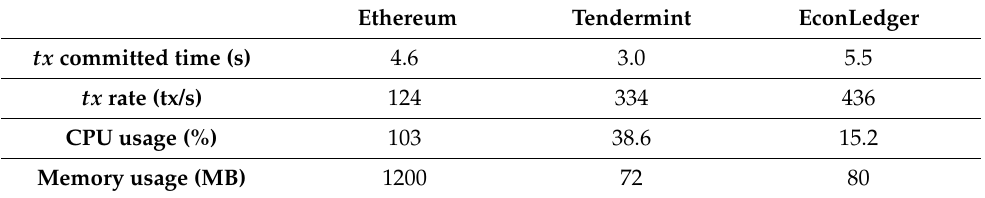
Table 4. Comparative evaluation of launching transactions on different blockchain